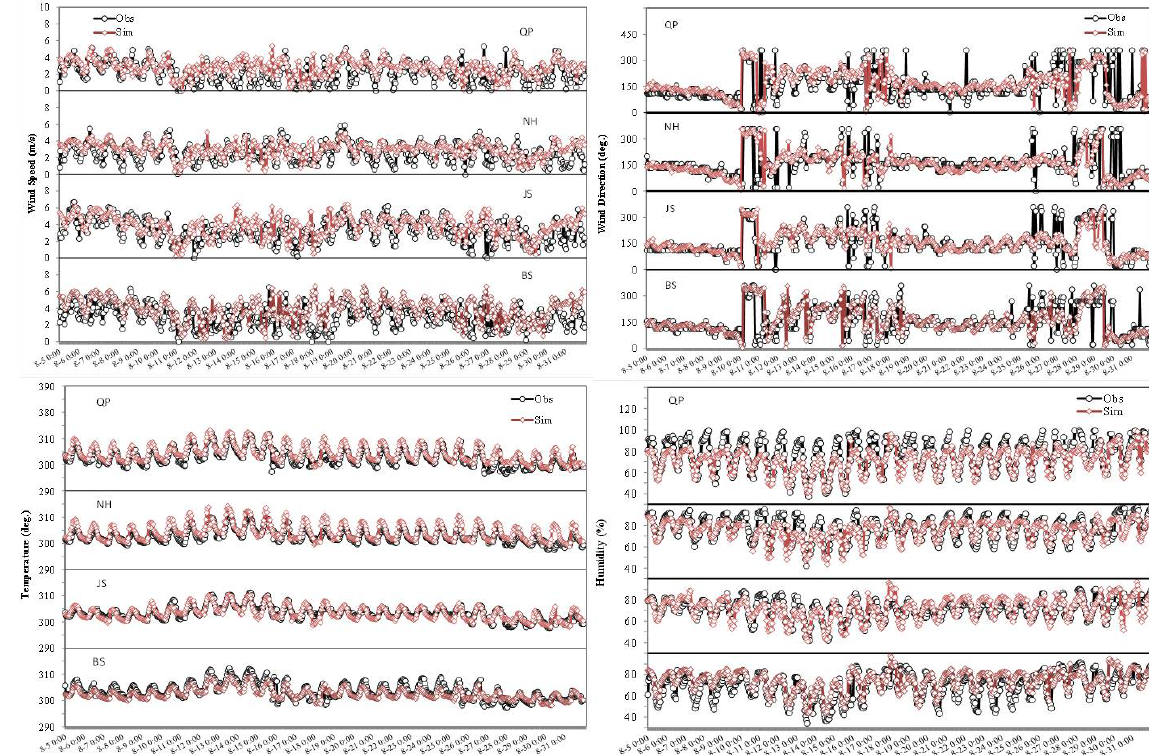
Fig. 6. Time series of simulated surface wind speed, wind direction, temperature and relative humidity compared with observations at four monitoring sites during 5–31 August 2010.